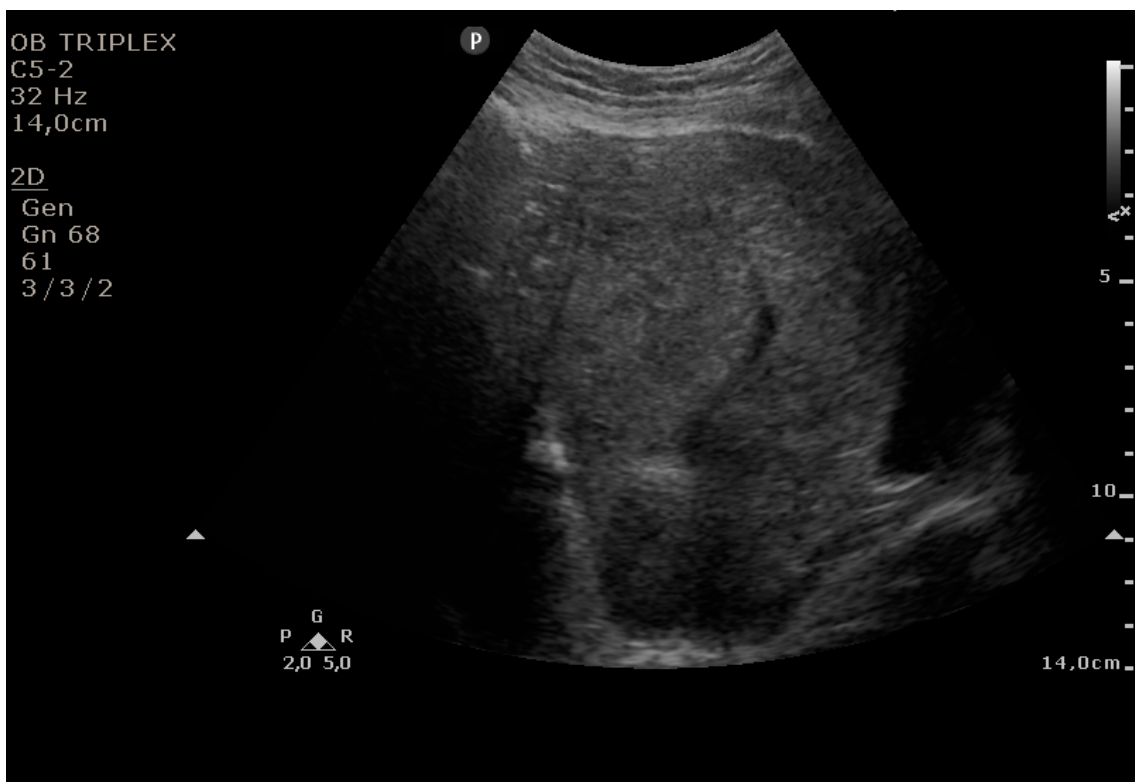
Figure 3. Grade 2: less than one-half of the endometrial length occupied by blood or debris.